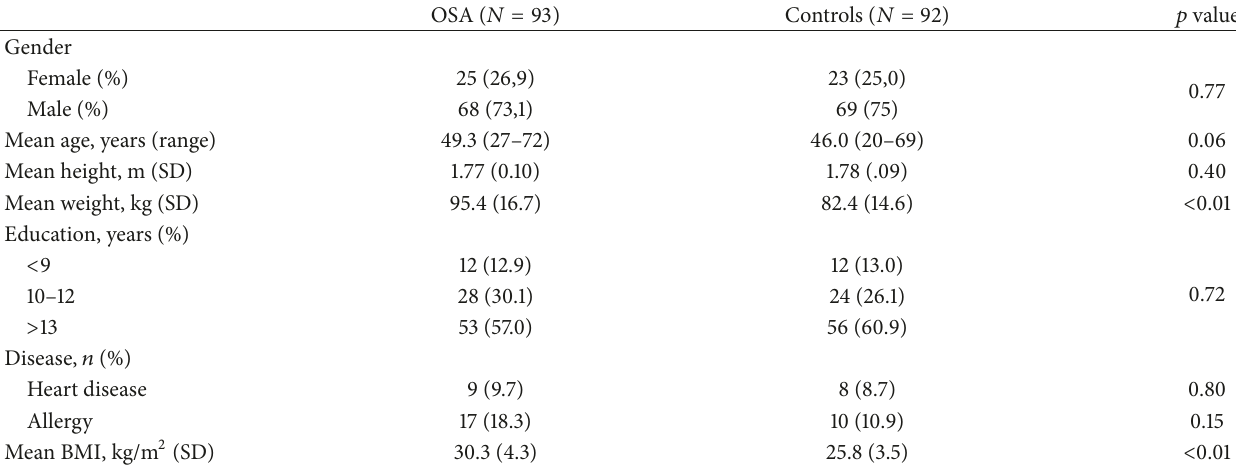
Table 1: Patient demographics.